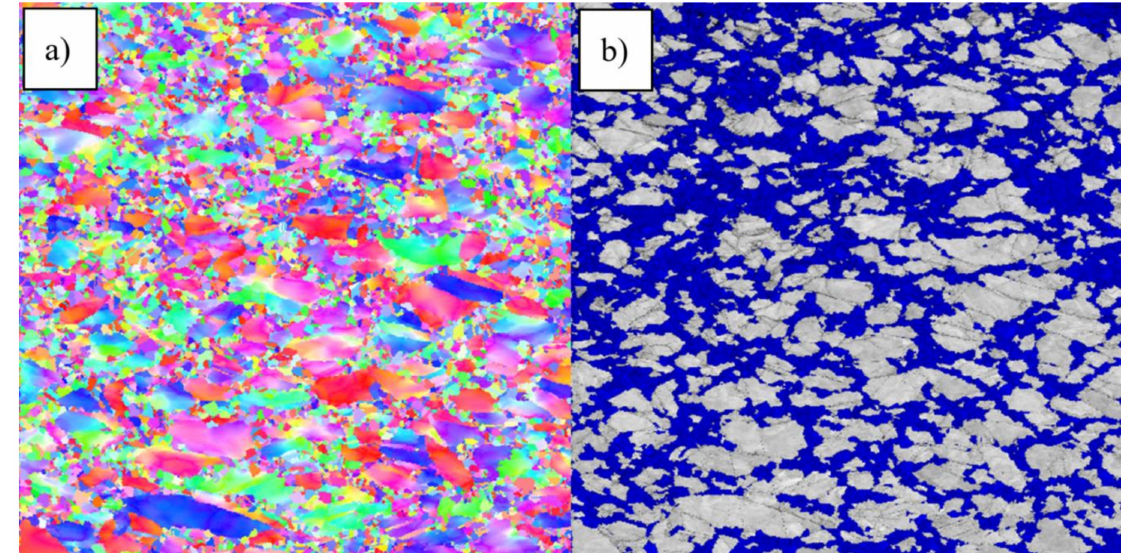
Figure 9. EBSD grain plot (980 ◦ C, 1 s − 1 , strain: 0.54 and 0 s holding time): ( a ) IPF map, ( b ) recrystallized grains colored in